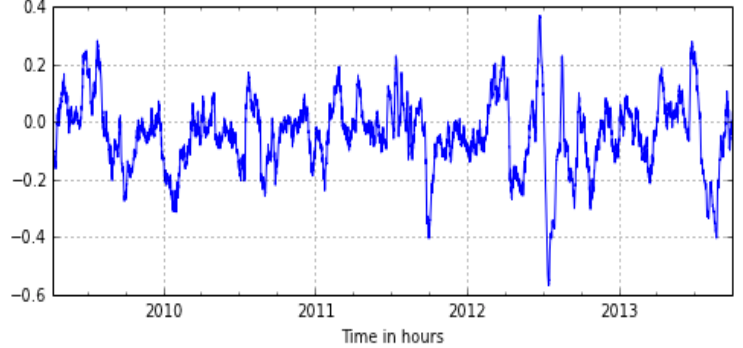
Figure A1. Rolling correlation between wind power capacity factor and the detrended load.